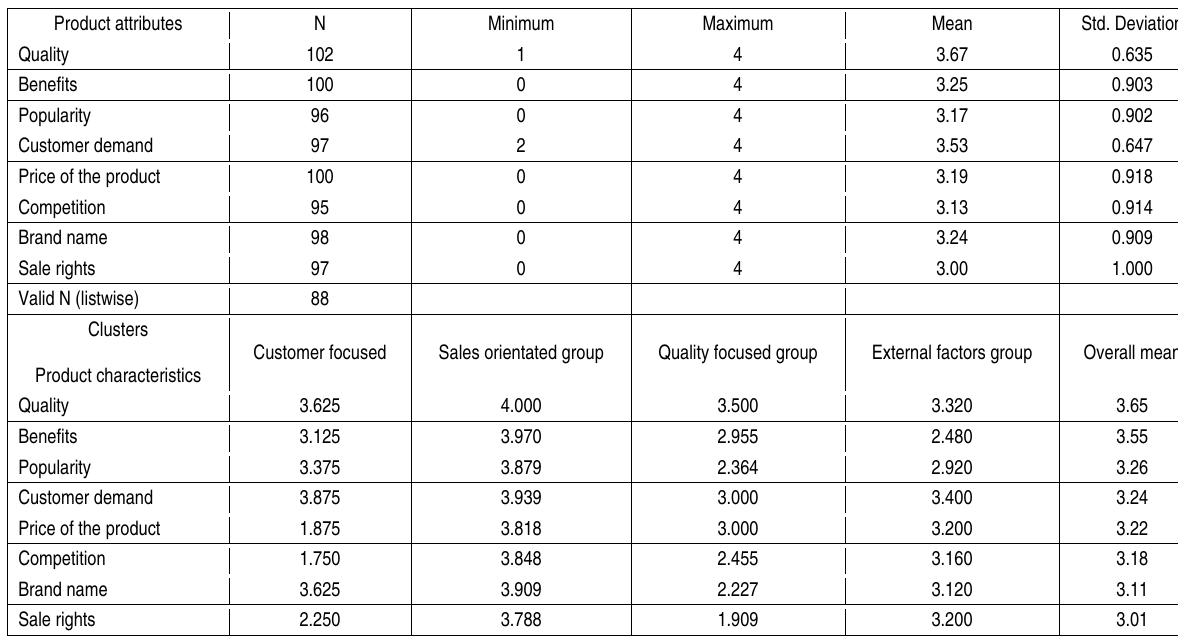
Table 1. Mean level of importance of product characteristics and